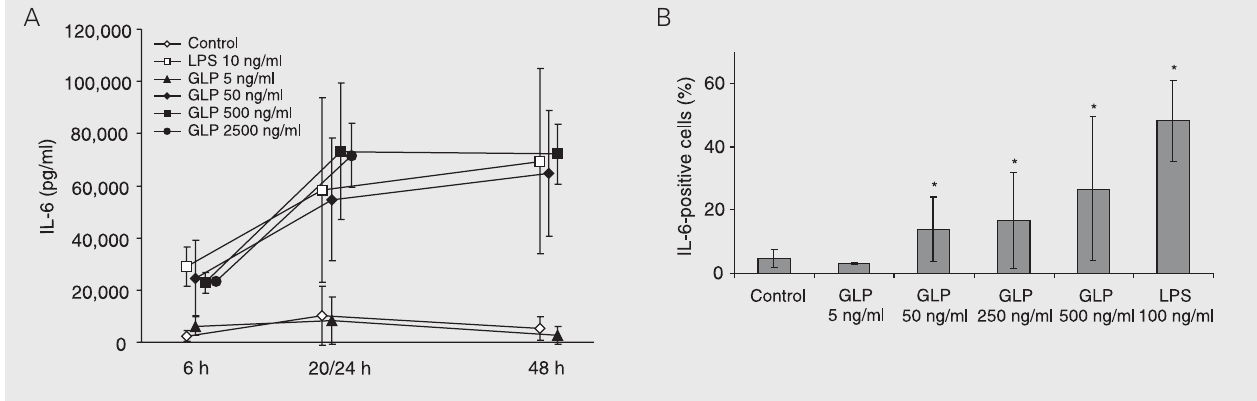
Figure 2. Kinetics of IL-6 release (A) and detection of IL-6 in monocytes in whole blood after stimulation with GLP (B). A , LPS was used as positive control. Peripheral blood mononuclear cells were stimulated with either Salmonella abortus equi LPS or Leptospira interrogans serovar Copenhageni GLP at the doses indicated and incubated for 48 h. Supernatants were collected after 6, 20/24, and 48 h and IL-6 was measured by ELISA. Results are reported as the mean ± SD for three to five experiments. GLP = glycolipoprotein; LPS = lipopolysaccharide. GLP ( ≥ 50 ng/ ml) versus control: P < 0.05 for 6 and 20/24 h and P = 0.08 for 48 h (Mann-Whitney test). B , The cytokine-producing cells are reported as the percentage of monocytes. Data are reported as means ± SD for six experiments. *P < 0.05 versus control (Mann-Whitney